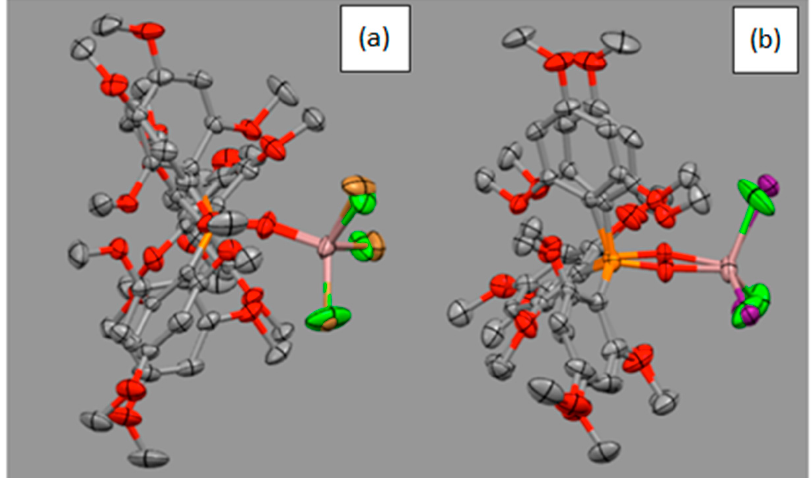
Figure 5 . Overlay of two molecular structures. ( a ): the Cl/I and ( b ): the Cl/Br adducts structures. The major (90%) and minor (10%) conformers were also present in a GaBr 3 –phosphine complex in